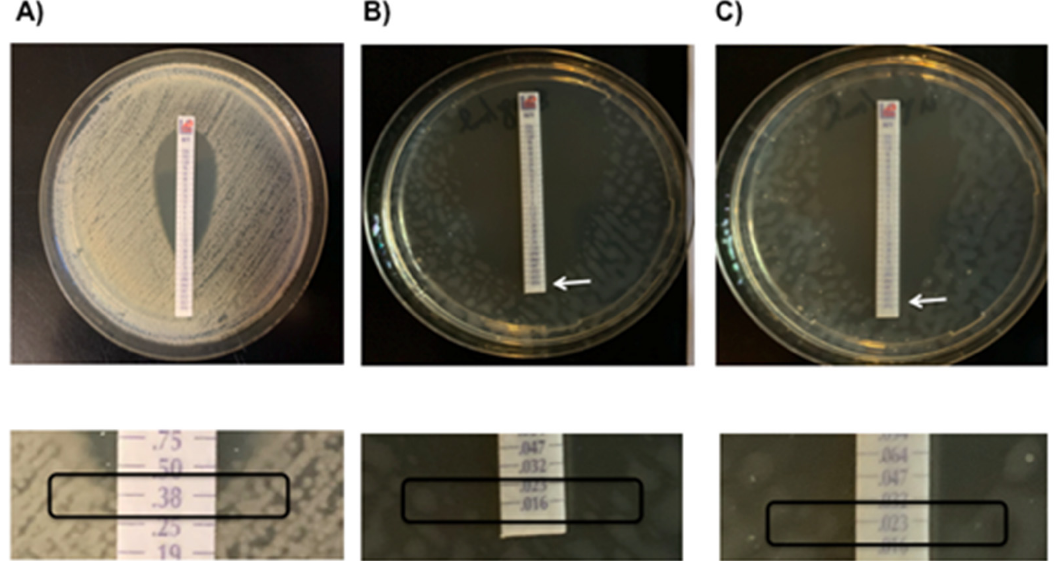
Figure 2. In vitro analyses of MVB ( A ) and MVB + FOS ( B , C ) against KPC-Kp strain isolated from the blood. Gradient strip test (E-test) showed MVB MIC of 0.38 μ g/mL (Panel A). Synergy tests showed that, in the presence of 0.5×MIC (8 μ g/mL) and 0.25×MIC (4 μ g/mL) of FOS, MVB MICs lowered to 0.016 and 0.023 μ g/mL, respectively. FOS MIC was determined with agar dilution method and was 16 μ g/mL (image not shown). Arrows indicate MVB MIC in the presence of FOS. MVB: meropenem/vaborbactam; FOS: fosfomycin. In the lower part of the figure, there is a magnification of the MVB MIC value in the presence of FOS.